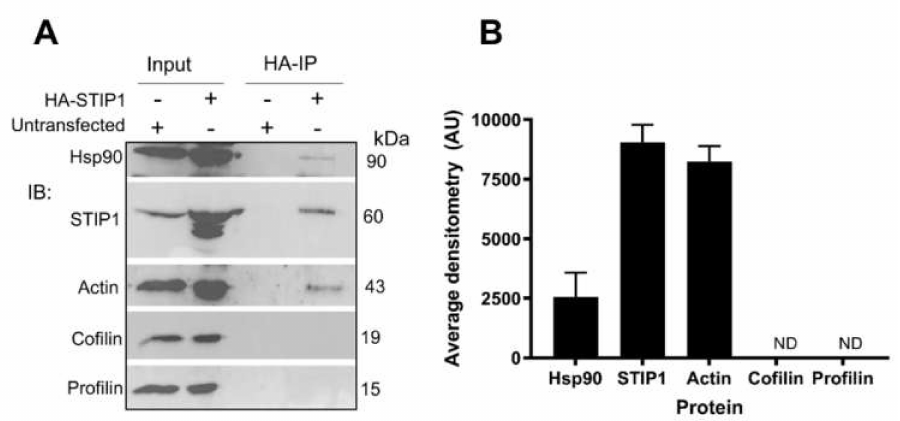
Figure 6. STIP1 and actin, but not cofilin and profilin could be isolated in a common complex. ( A ) Western blotting and ( B ) average densitometry ( ± SD, n = 3) of complexes from HA-immunoprecipitation experiments from untransfected or HA-STIP1-transfected HEK293T cells. ND = not